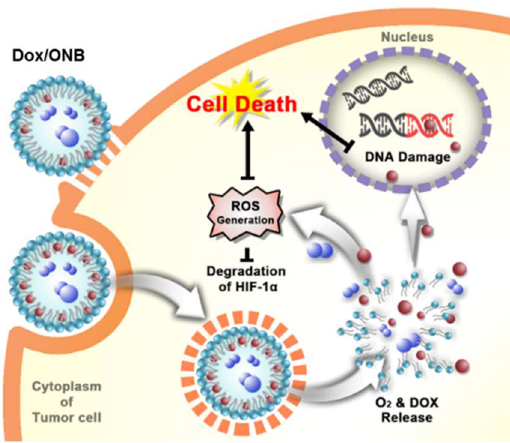
Figure 1. Schematic of doxorubicin-loaded oxygen nanobubble (Dox/ONB) and the working mechanism of Dox/ONBs inside a tumor cell.